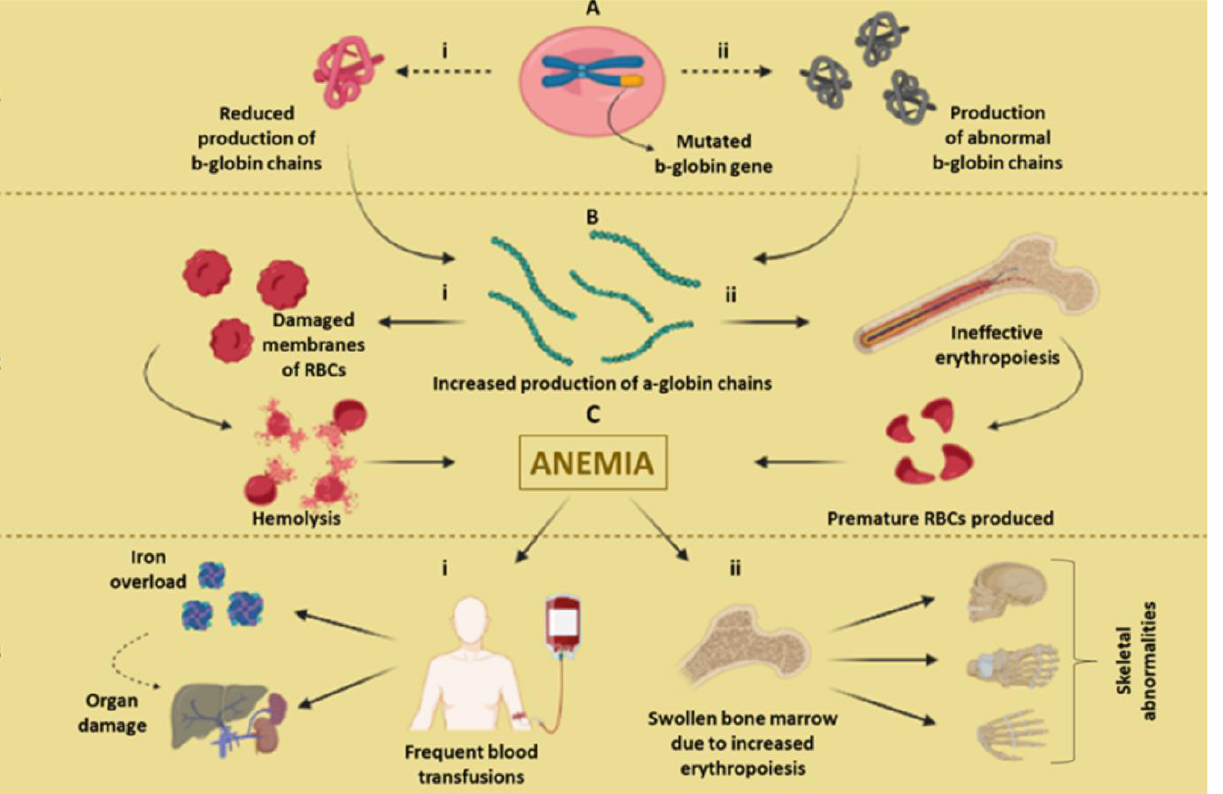
Figure 1. ( 1A ) The beta-globin gene responsible for producing beta-globin chains of hemoglobin is mutated due to either (i) production of b-globin chains being reduced, or (ii) abnormal b-globin chains being produced. ( 2B ) Abnormality of b-globin chains causes increased production of a-globin chains due to either (i) the membranes of RBCs getting damaged causing hemolysis, or (ii) RBC precursors in the bone marrow getting precipitated causing ineffective erythropoiesis, premature death, or premature production of RBCs. ( 2C ) Hemolysis and ineffective erythropoiesis cause anemia. ( 3 ) To overcome anemia, either (i) frequent blood transfusions are required, which ultimately cause iron overload and organ damage, or (ii) vigorous signals to increase the RBC production causes the swelling of the bone marrow, which causes skeletal abnormalities.